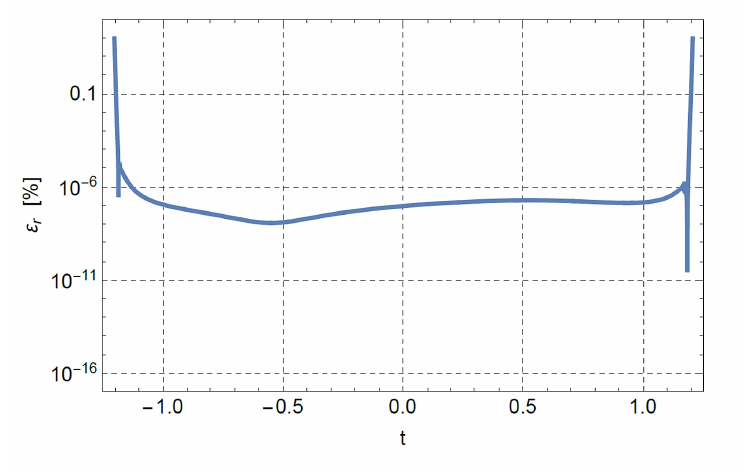
Figure 16. Relative percentage error of the Bell’s approximation of F ( t ) in